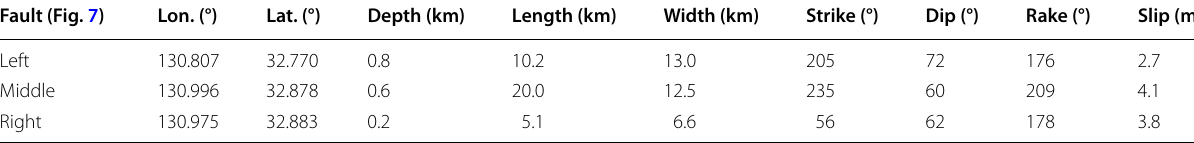
Table 3 Fault models of the Kumamoto earthquakes (Geospatial Information Authority of Japan 2016) Fault (Fig. 7) Left